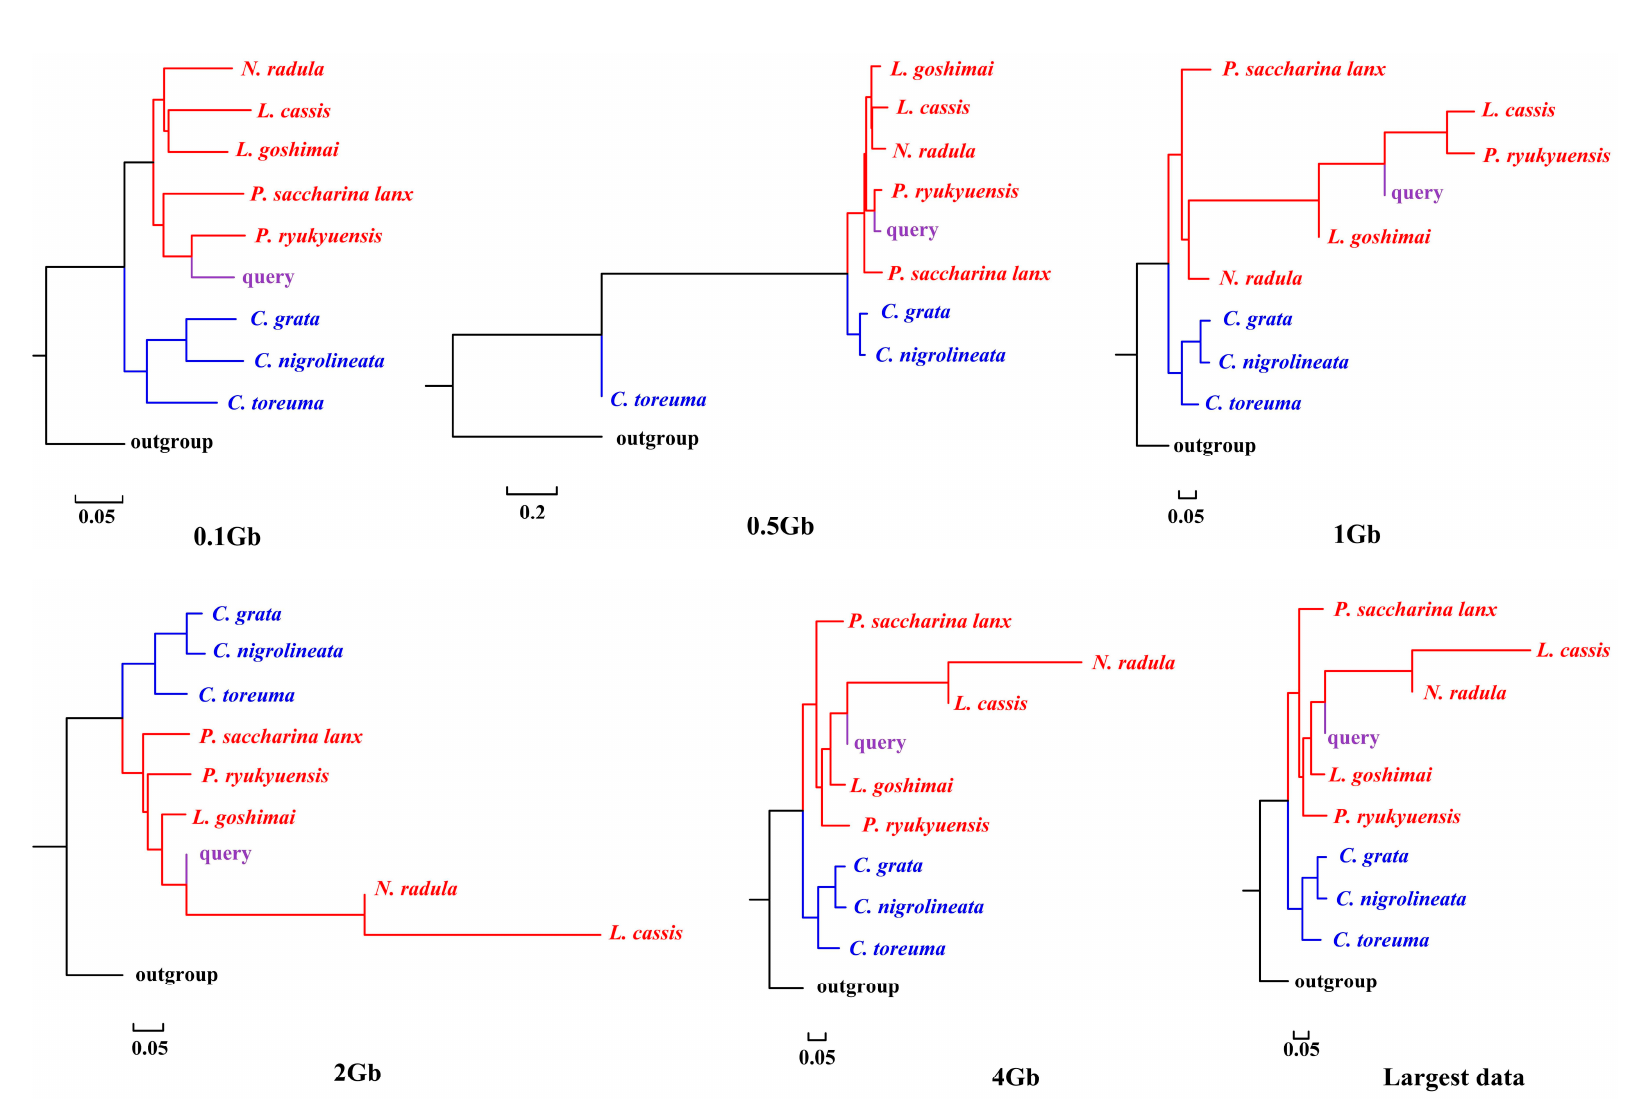
Figure 4. Phylogenetic placement of P. conulus (query species) under different sizes of genome skims.